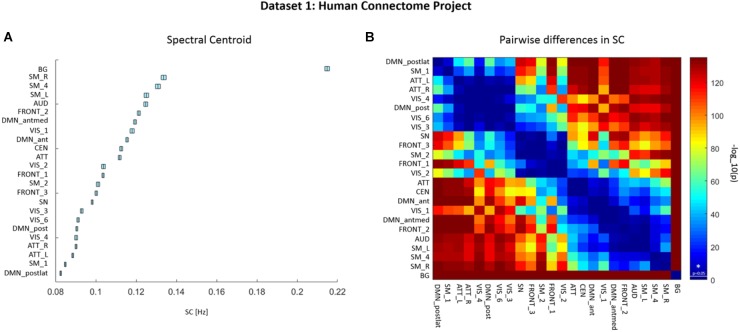
Dataset 1: (A) Mean ± SEM spectral centroid (SC) values of each RSN from Human Connectome Project (HCP) data of 820 healthy subjects. RSNs are ordered according to increasing SC magnitude. SCs were calculated based on power spectra of BOLD network fluctuations within the frequency range of 0.01–0.69 Hz. (B) Matrix representing p-values of pairwise differences in the SC between individual RSNs. The colors indicate the significance, where red stands for lower p-value and higher significance, and blue for higher p-value thus lower significance. P-values were scaled with a –log10(p) transform, the colorbar value of 1.3 corresponds to p = 0.05 (as indicated by a vertical line across the colorbar and an asterisk which represent significance threshold).